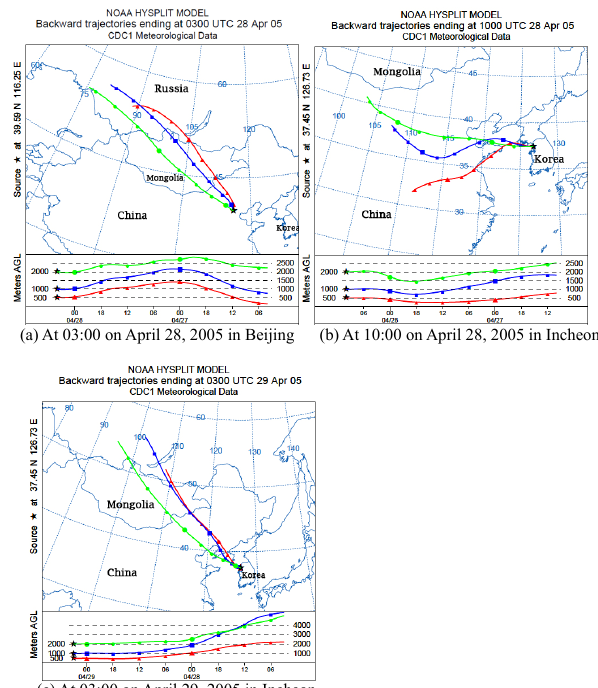
Fig. 3. 48 h backward trajectories of air masses ending (a) at 03:00 UTC on April 28, 2005 in Beijing; (b) at 10:00 UTC on April 28, 2005; and (C) at 03:00 UTC on April 29, 2005 in Incheon. Trajectory plots were produced with HYSPLIT from the NOAA ARL website: http://www.arl.noaa.gov/ready/.